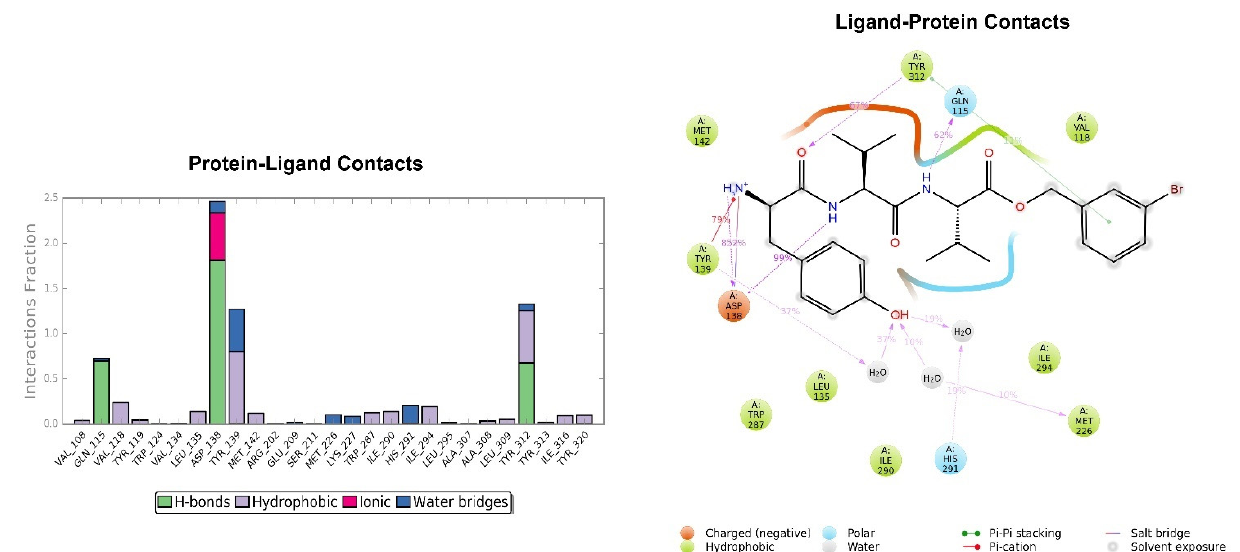
Figure 8. Key interactions of H-D-Tyr-Val-Val-O-(3-Br)-Bz ( 6 ) with KOR binding pocket expressed in %. Hydrogen bonds are in violet lines.